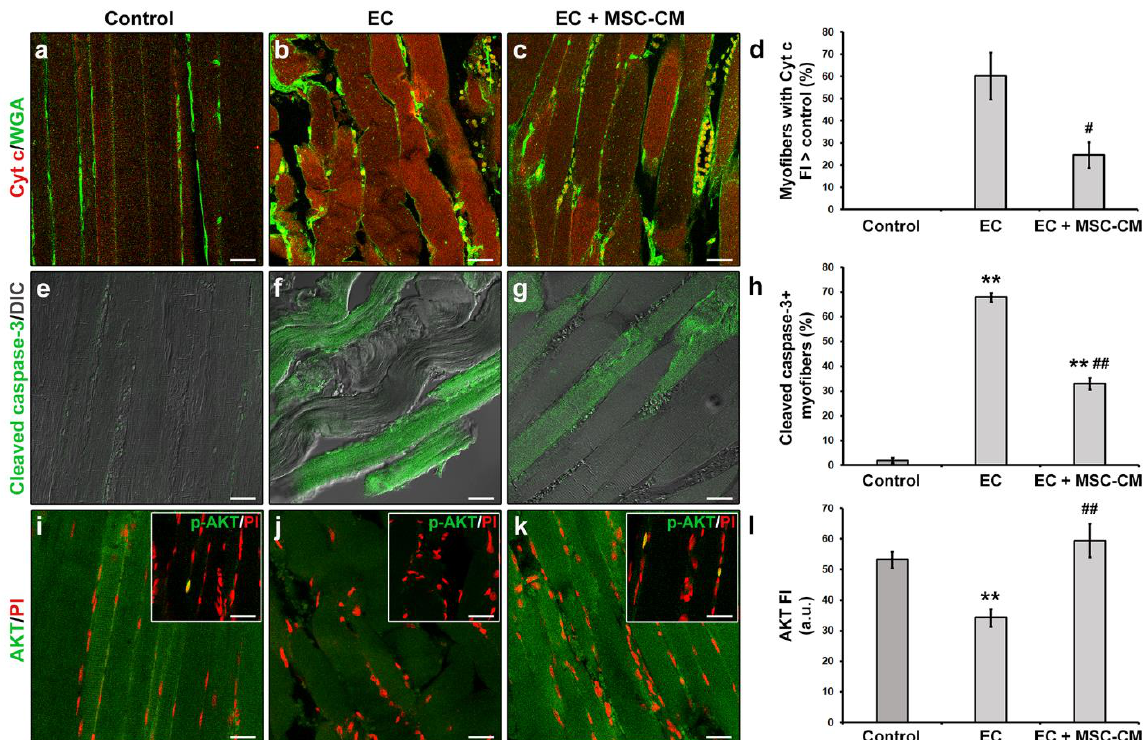
Figure 2. Morphological analyses of formalin-fixed and paraffin-embedded tissue sections from control EDL muscles, EDL muscles damaged by ex vivo forced eccentric contraction (EC) and EDL muscles damaged by EC in the presence of bone marrow-mesenchymal stromal cell (MSC) conditioned medium (EC + MSC-CM). ( a–c ) Representative confocal immunofluorescence images of muscle tissue sections immunostained with antibodies against cytochrome (Cyt) c (red) and counterstained with the membrane dye wheat germ agglutinin (WGA) (green). ( d ) Quantitative analysis of the percentage of myofibers with Cyt c fluorescence intensity (FI) higher than that of control. ( e–g ) Representative superimposed confocal immunofluorescence and differential interference contrast (DIC, grey) images of muscle tissue sections immunostained with antibodies against the pro-apoptotic marker activated/cleaved caspase-3 (green). ( h ) Quantitative analysis of the percentage of cleaved caspase-3 + myofibers. ( i–k ) Representative confocal immunofluorescence images of muscle tissue sections immunostained with antibodies against the pro-survival/anti-apoptotic factor AKT (green) and counterstained with the nuclear dye propidium iodide (PI, red). Insets: representative confocal immunofluorescence images of muscle tissue sections immunostained with antibodies against the activated phosphorylated form of AKT (p-AKT, green) and counterstained with PI (red). Images are representative of at least 3 sections from each of 4 control, 4 EC and 4 EC + MSC-CM muscles. Scale bars = 25 μm. ( l ) Quantitative analysis of AKT FI. a.u.: arbitrary units. Values are mean ± SEM. ** p < 0.01 vs. control; # p < 0.05 and ## p < 0.01 vs. EC.